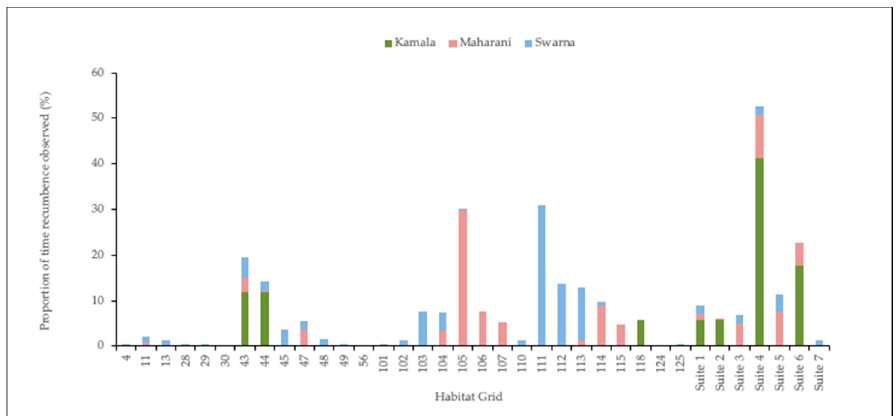
Figure 10. Distribution of the behavior “Recumbence” throughout the habitat of a single social group. Clear separations were observed in preferred sleeping areas and noticeable trends in sleep proximity within adjacent areas were observed among elephants.